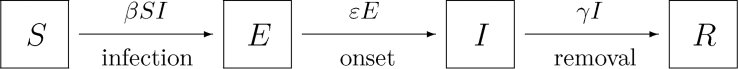
Transfer diagram for the SEIR model.